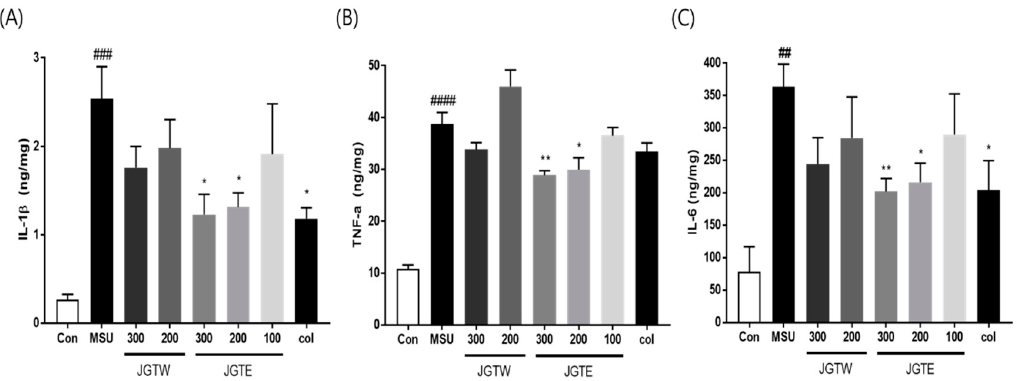
Figure 5. E ff ects of JGTW and JGTE on expression levels of proinflammatory cytokines in MSU crystal-injected paw tissue. Con, control mice; MSU, MSU crystal-injected mice; JGTW, MSU-injected mice treated with JGTW; JGTE, MSU-injected mice treated with JGTE; Col, MSU-injected mice treated with 1 mg / kg of colchicine. The levels of ( A ) interleukin (IL)-1 β , ( B ) tumour necrosis factor (TNF)- α , and ( C ) IL-6 were measured by ELISA. Data are presented as the mean ± SEM ( n = 5). ## p < 0.01, ### p < 0.001, #### p < 0.0001 vs. Control group and * p < 0.05, ** p < 0.01 vs. MSU group.